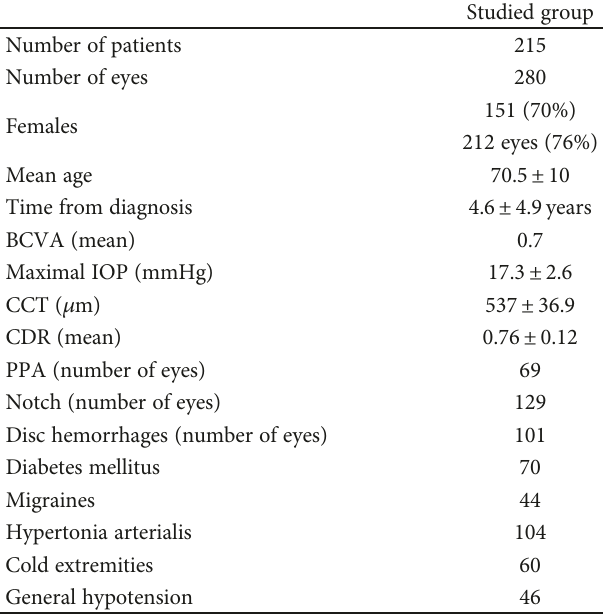
Table 1: Demographic characteristic of the studied